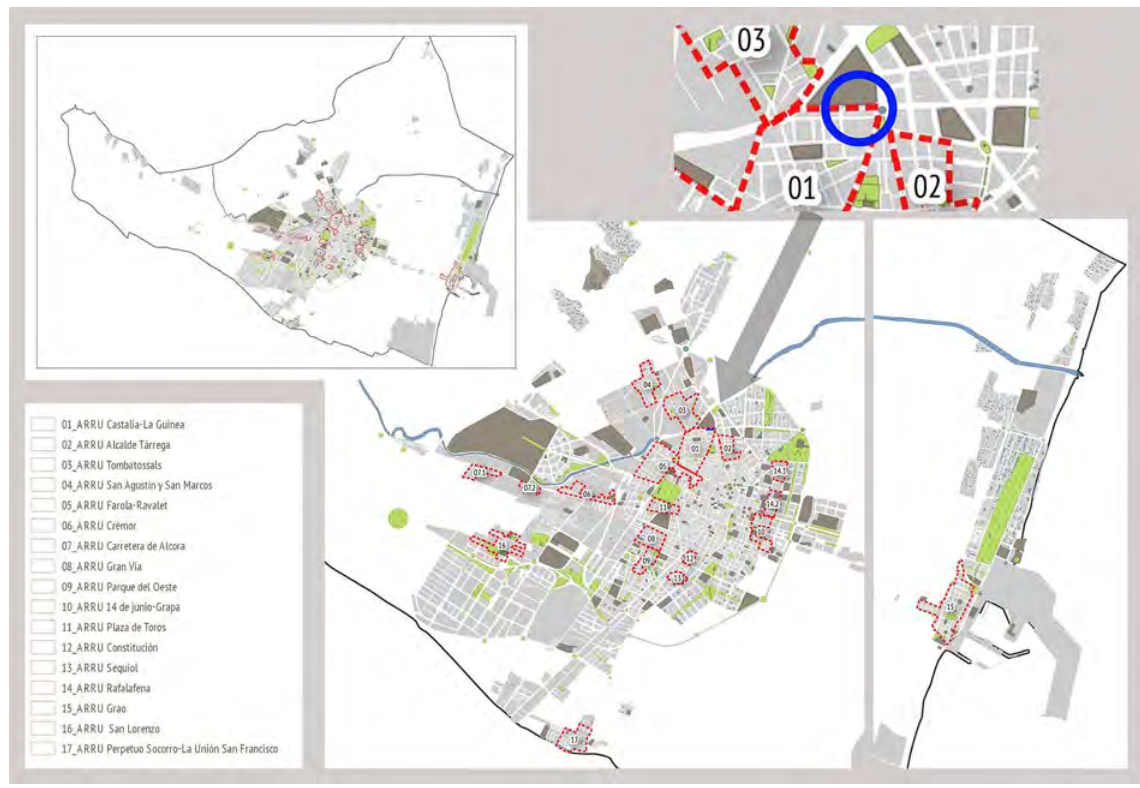
Figure 2. Situation